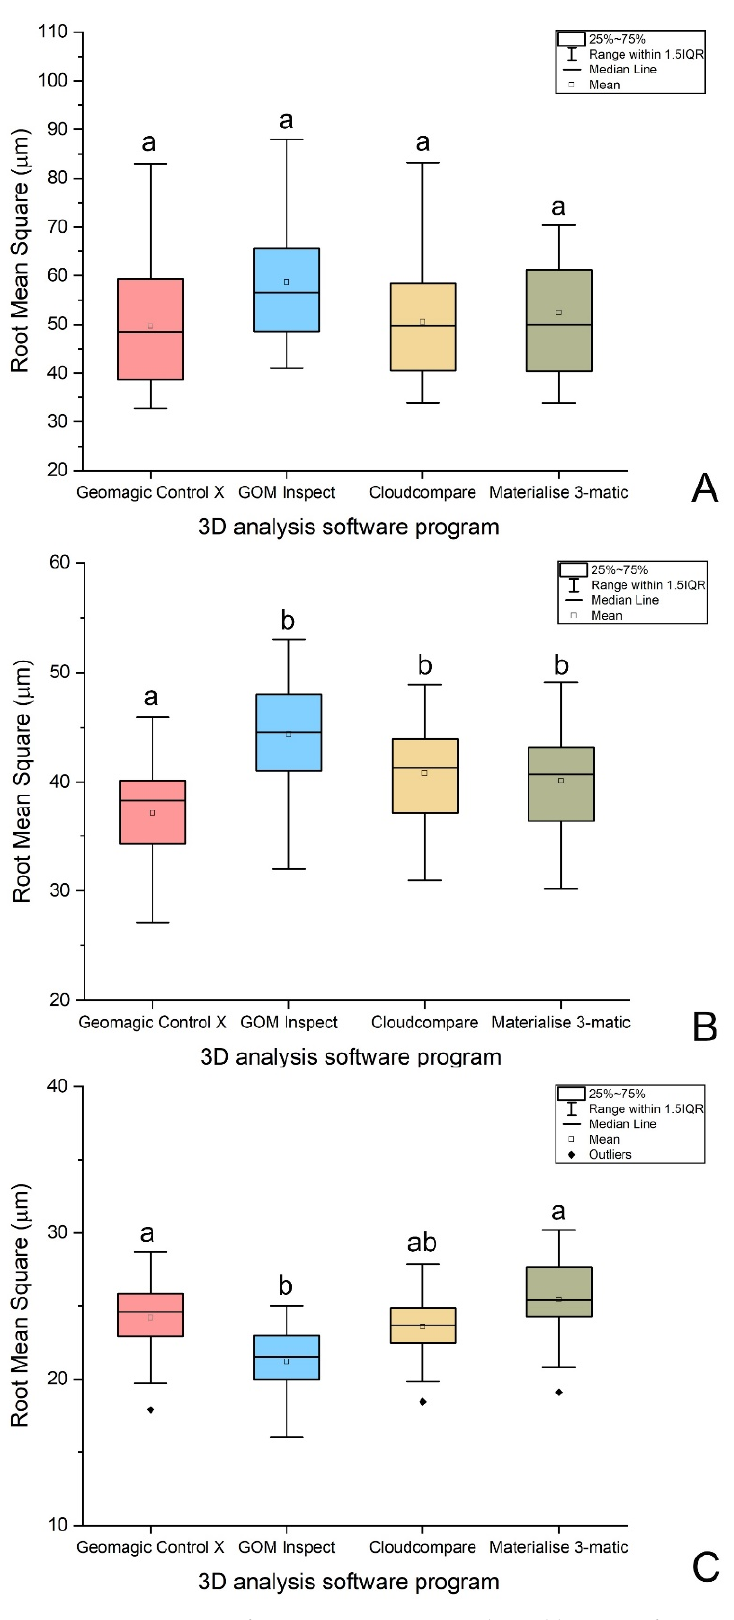
Figure 6. Comparison of root mean squares evaluated by using four analysis software programs. ( A ) Complete-arch region; ( B ) Half-arch region; ( C ) Tooth preparation region. The letters (a and b) indicate significant differences among software program groups using Tukey HSD test, p < 0.05.